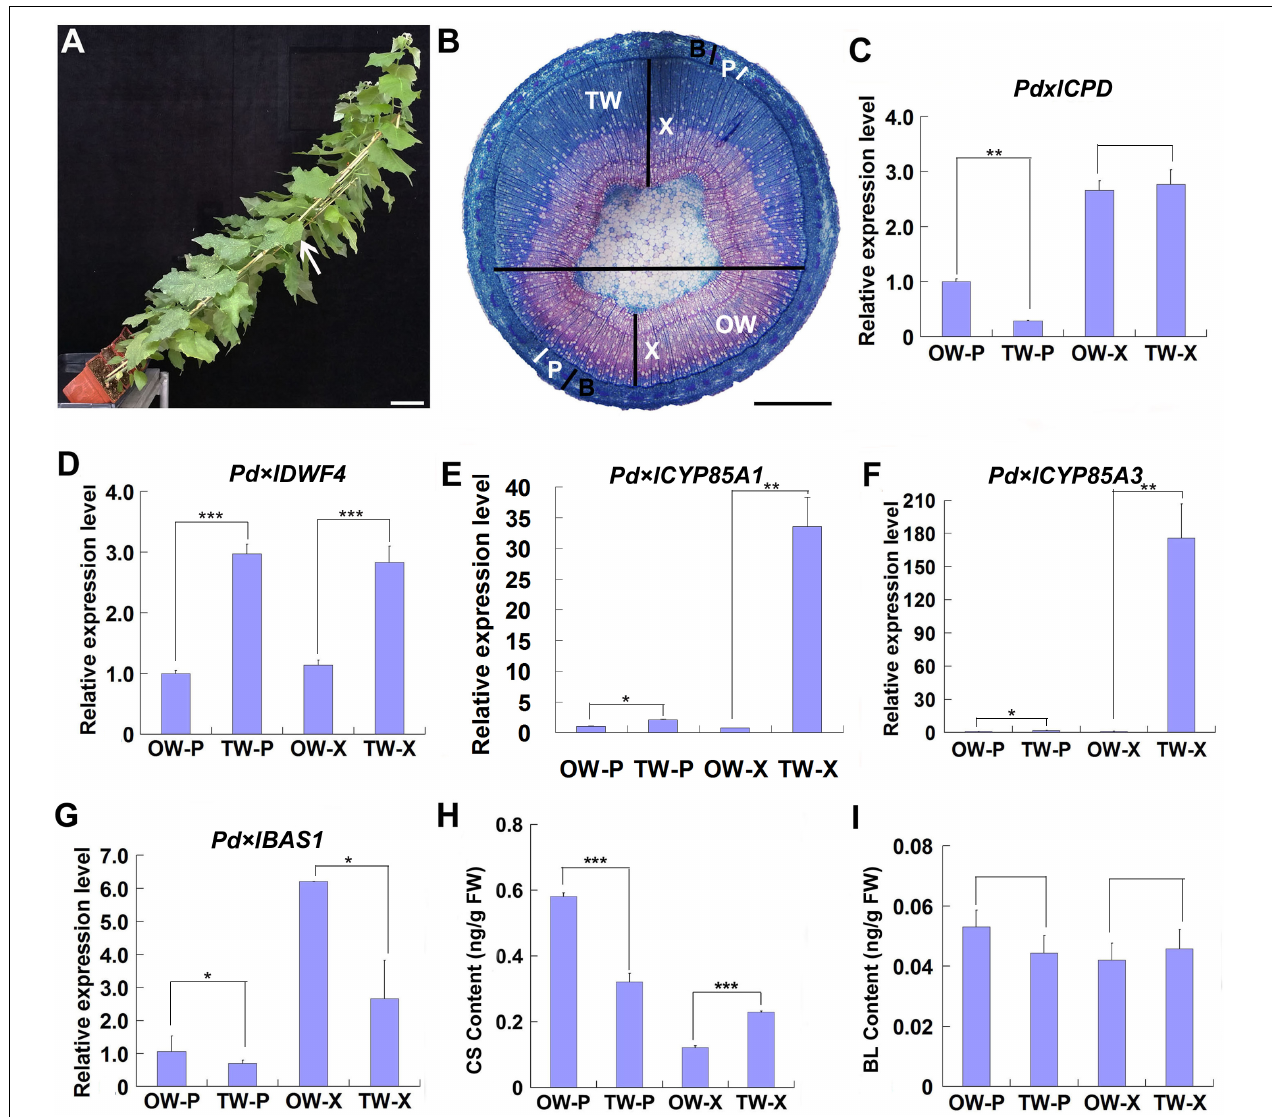
FIGURE 1 | Gene expression and BR content analyses during TW formation. Two-month-old wild type Shanxin yang plants (WT) were fixed to sticks and grown at an angle of 45 ◦ in greenhouse to induce TW formation. (A) Poplar plants grown in greenhouse for TW induction. Bar = 5 cm. The stem position used for safranin-O and astra-blue staining was indicated with a whit arrow. (B) Cross sections from the middle part of the inclined stem were stained with safranin-O and astra-blue. TW was stained into blue color. The horizontal line indicates the division of TW side and OW side. Bar = 1 mm. TW, tension wood; OW, opposite wood; X, xylem tissues; P, phloem tissues; B, bark including phloem tissues. The white bars indicate phloem. (C–F) Relative expression of putative BR biosynthesis and metabolic genes in poplar. The expression levels of Pd × lCPD (C) , Pd × lDWF4 (D) , Pd × lCYP85A3 (E) , and Pd × lBAS1 (F) in different tissues of reaction wood were determined. Expression in the phloem tissue of OW was set to 1. Error bars represent the SDs from three biological replicates. (G,H) Content analyses of CS (G) and BL (H) in different tissues of reaction wood. OW-P, phloem tissues on opposite wood side; TW-P, phloem tissues on tension wood side; OW-X, xylem tissues without any pith on opposite wood side; TW-X, xylem tissues without any pith on tension wood side; BL, brassinolide; CS, castasterone. Data were means ± SD ( n = 9) of three independent biological replicates with three technical replicates each. *, **, and *** indicate significant difference at P < 0.05, P < 0.01, and P < 0.001, respectively (Student’s t -test). Gene Potri ID numbers were provided in Supplementary Table S1